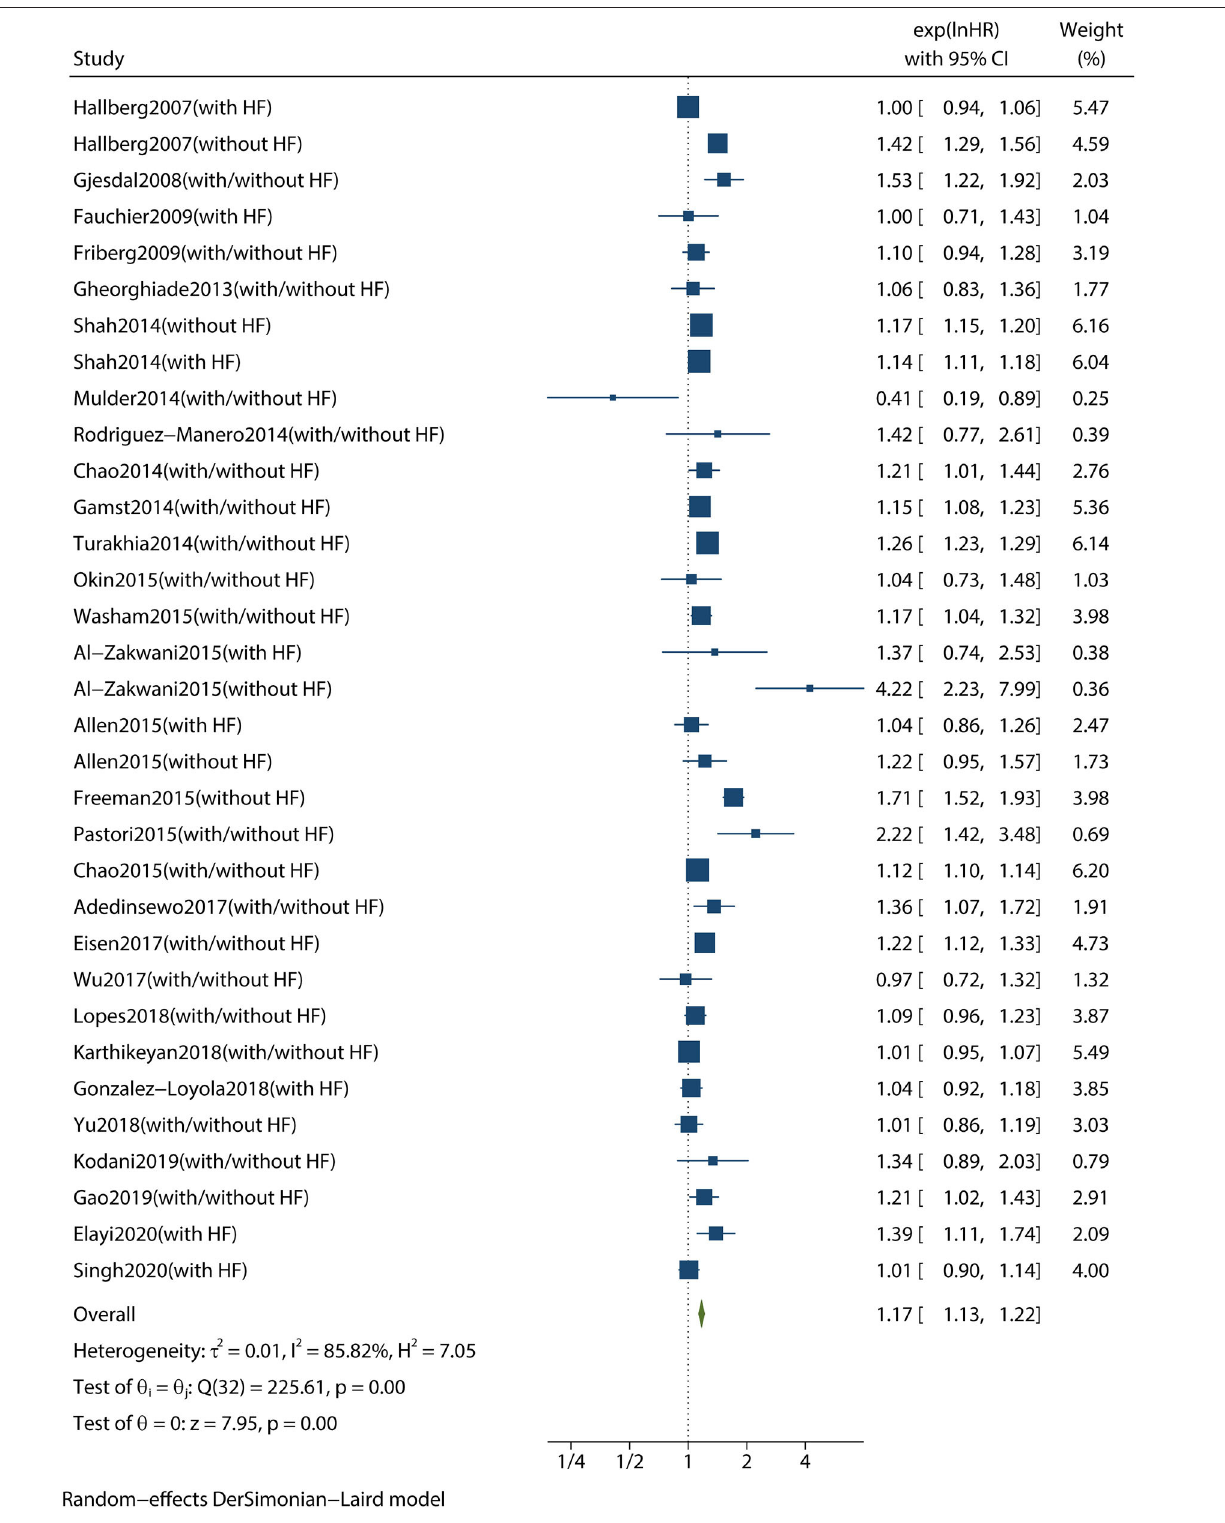
Frontiers in Cardiovascular Medicine |